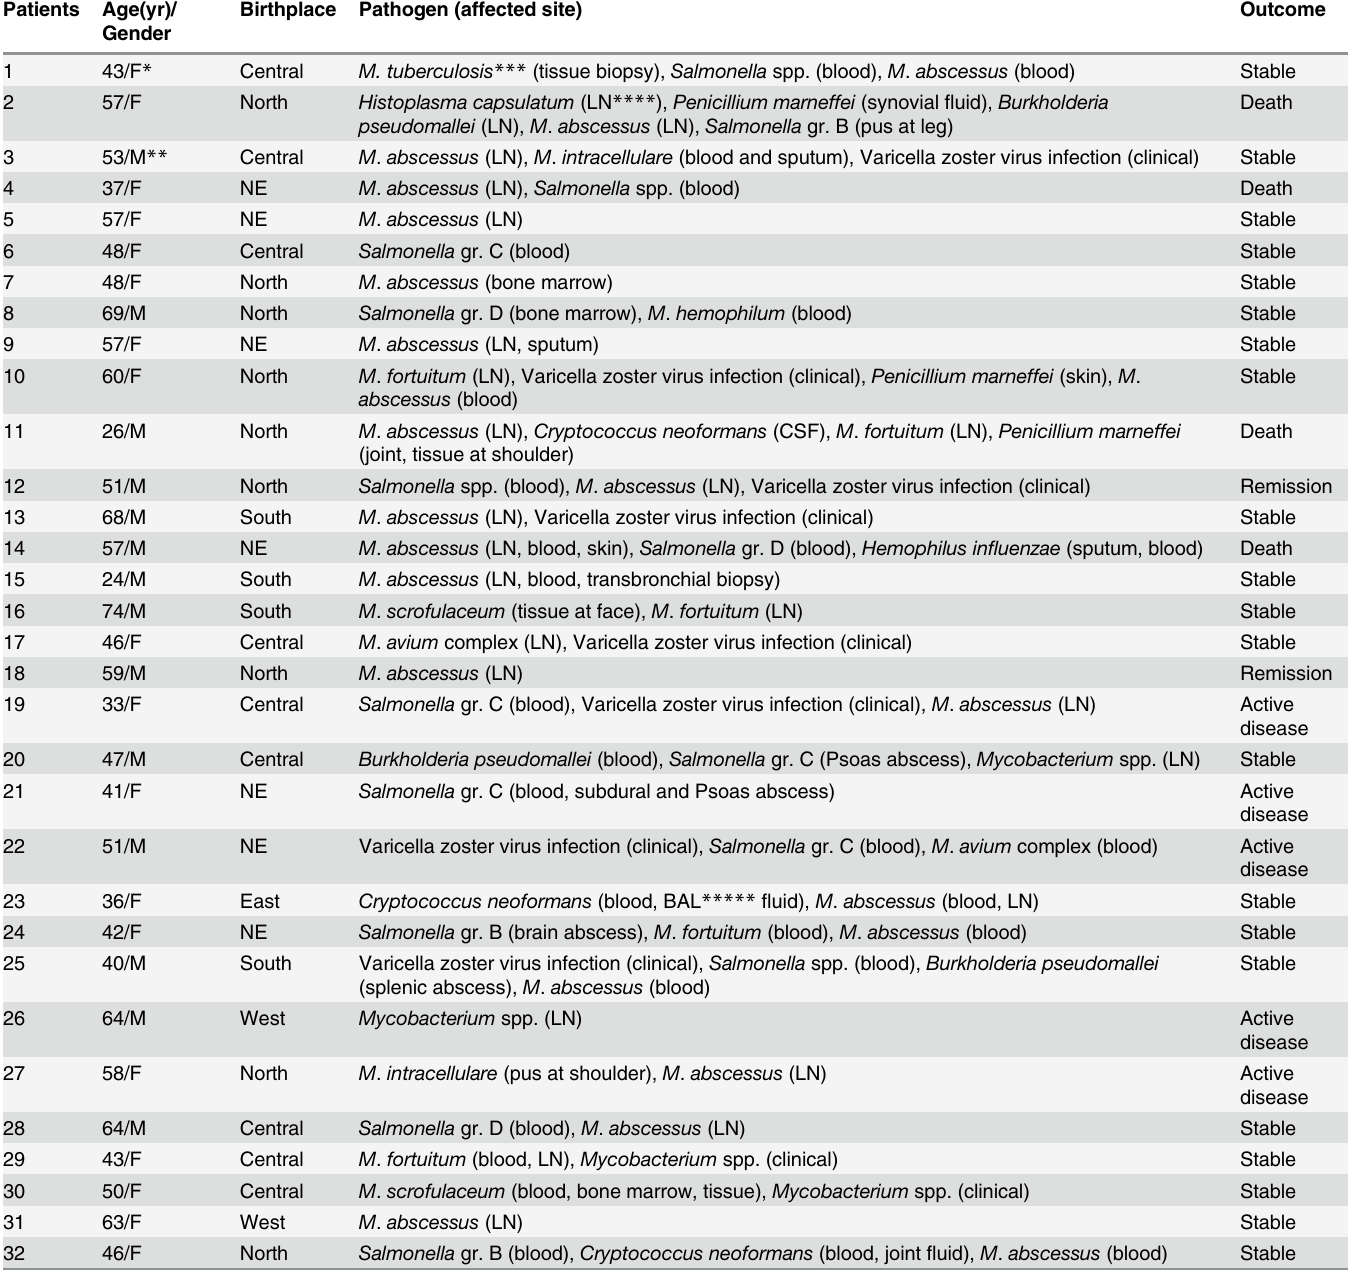
Table 1. Demographic characteristics, pathogen, affected site and outcome of patients with disseminated non-tuberculous mycobacterial infec- tions or other opportunistic infections who had positive anti-IFN- γ autoantibody. Patients Age(yr)/